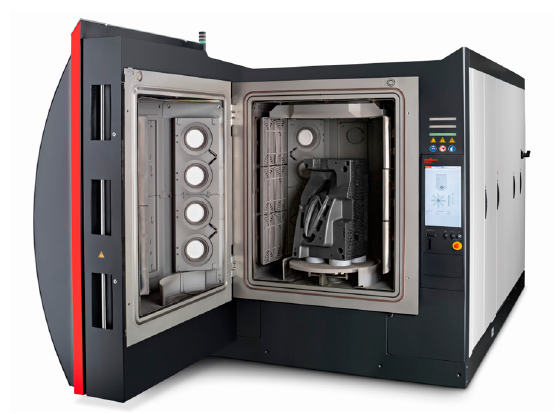
Figure 2. Medium-sized arc system equipped with circular arc evaporators, diameter 0.7 m, height 0.9 m, courtesy of Oerlikon